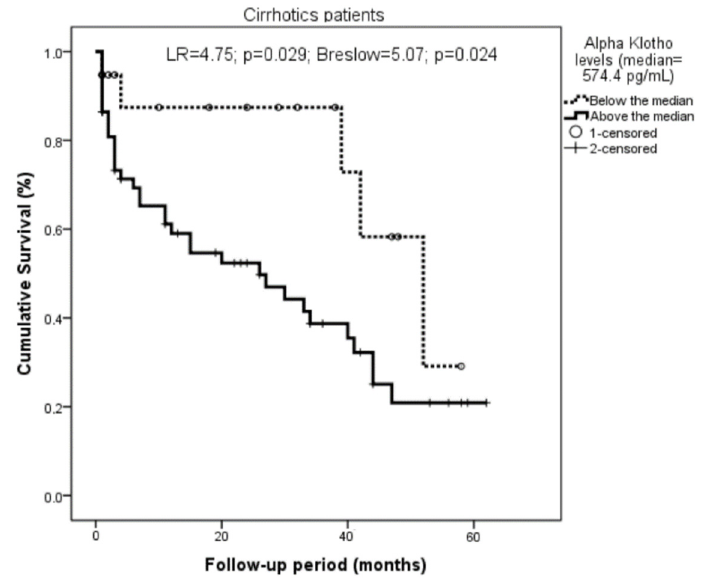
Figure 4. Relationship of Klotho with survival among the cirrhotics. Klotho levels were classified according to the median (574.4 pg/mL). Cirrhotic patients with Klotho values above the median showed higher mortality (LR = 4.75; p = 0.029; Breslow = 5.07; p = 0.024). Survival was also marginally related to MDA (with LR = 2.87, p = 0.09, Breslow = 3.75, and p = 0.05) but not in cirrhotics only. The TNF- α was also related to mortality (with LR = 5.77, p = 0.016, Breslow = 3.93, and p = 0.047 (Figure 5)) but not in cirrhotics (with LR = 1.00, p = 0.32, Breslow = 2.13, and p = 0.15).